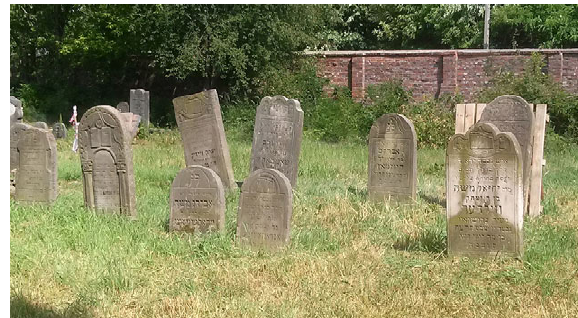
Fig. 12. Matzevahs in the historical Jewish cemetery in Pruszków are made mainly of the so-called Kunów sandstone (lower Jurassic), exploited in the vicinity of Kunów near Ostrowiec Świętokrzyski.Photo by M. Górska-Zabielska